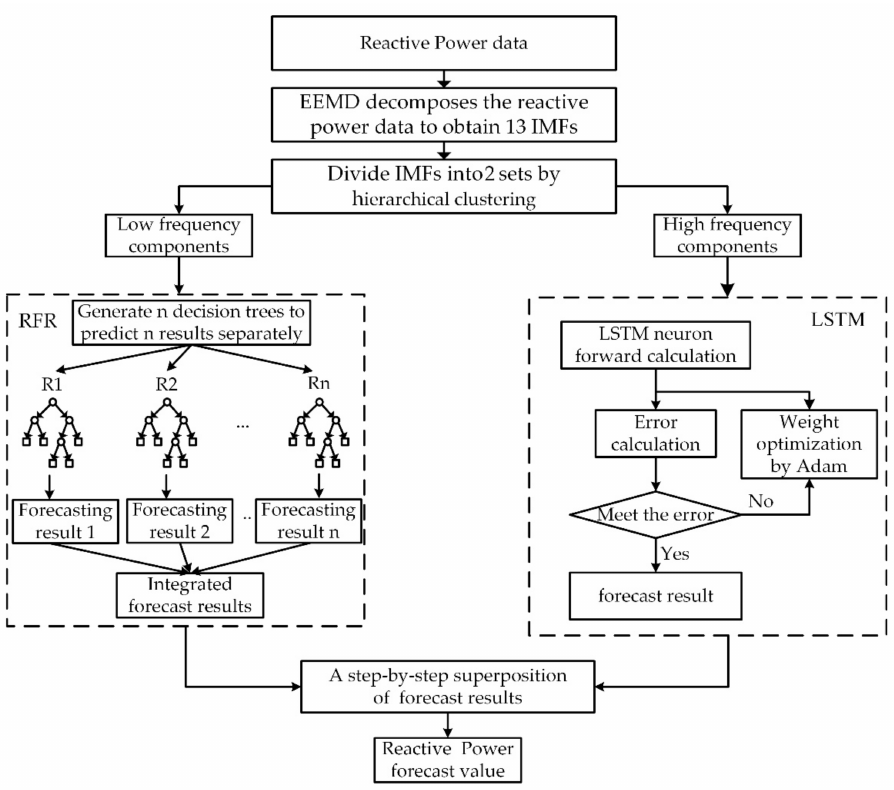
Figure 7. EEMD-LSTM-RFR hybrid forecasting